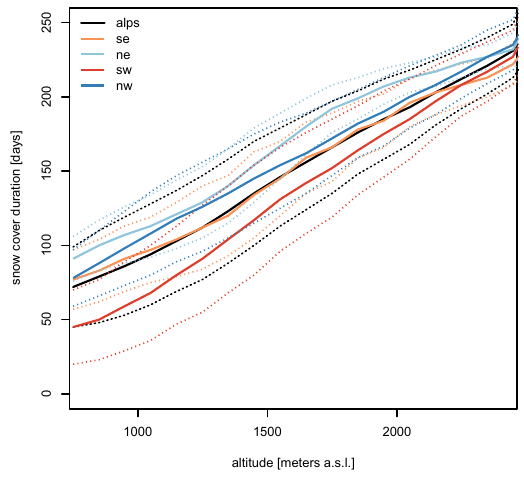
Fig. 6. SCD as a function of altitude for the Alps and the four regions separately. Bold lines represent the altitude mean SCD while the dotted lines indicate the standard deviation. The analysis was done at elevation steps of 100m.